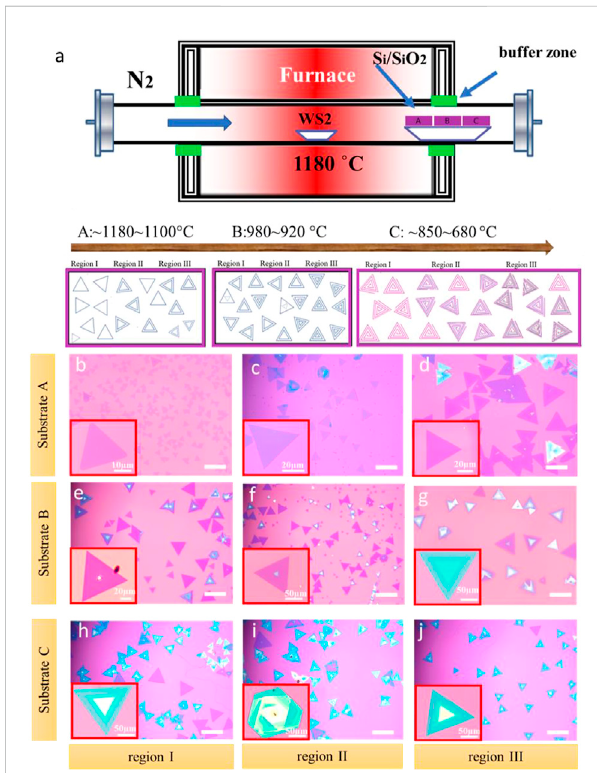
FIGURE 1 Controllable growth and Optical image of the Layer-By-Layer StructuresandSpiralStructuresofWS 2 (A) SchematicIllustrationofthe PVDexperimentsetupforTMDsynthesis.ThedistributionofWS 2 from the substrate of (A – C) : Monolayers, Bilayers. A few layers, Layer- By-Layer (LBL) and spiral structures. (B – D) The optical images of Ⅰ (monolayer), Ⅱ (a mixture of bilayers and trilayer) and Ⅲ (few layers) regions on substrate (A) (E – G) The optical images of Ⅰ and Ⅱ (multilayers) and Ⅲ (layer by layer) regions on substrate (B) (H – J) The optical images of Ⅰ (single-spiral pattern), Ⅱ (double-spiral patterns) and Ⅲ (multi-spiral patterns) regions on substrate (C)